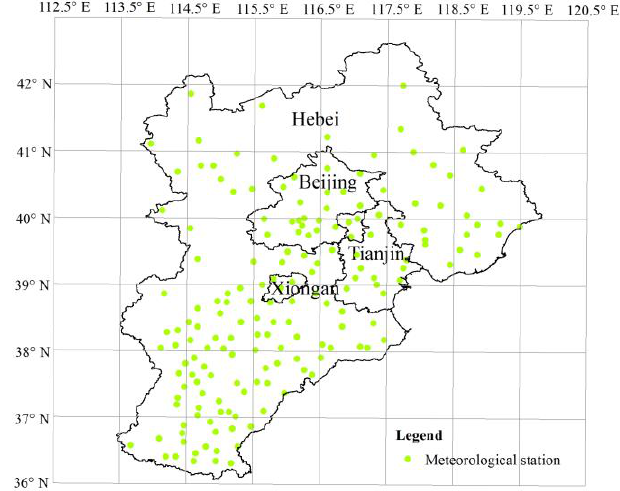
Figure 1. The locations of meteorological stations and the grid boxes’ layout of GCMs in the Beijing-Tianjin-Hebei region, China.